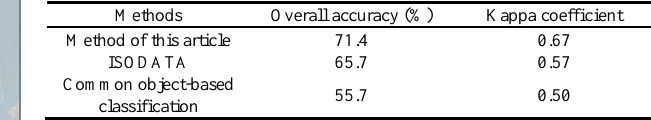
Table 3. Comparison of Classification accuracy